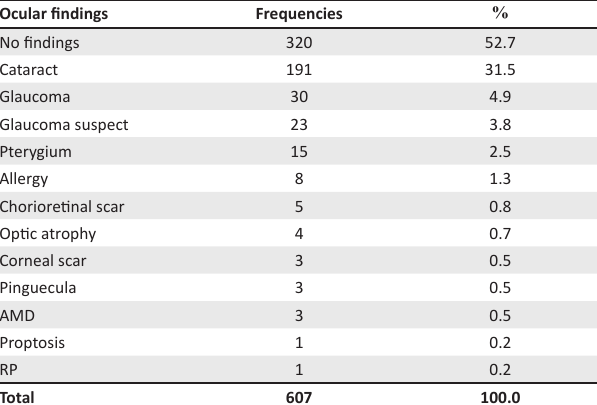
TABLE 4: Ocular findings in the 607 study participants, in order of greatest occurrence. Ocular findings